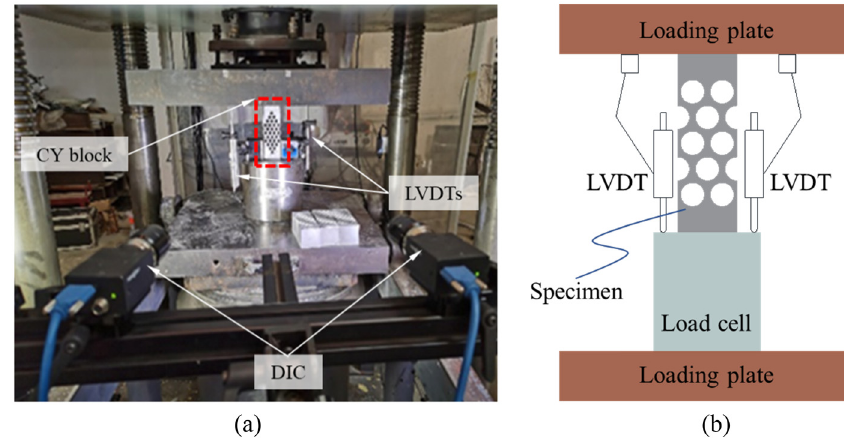
Figure 4: Test setup: ( a ) loading protocol and DIC system and ( b )